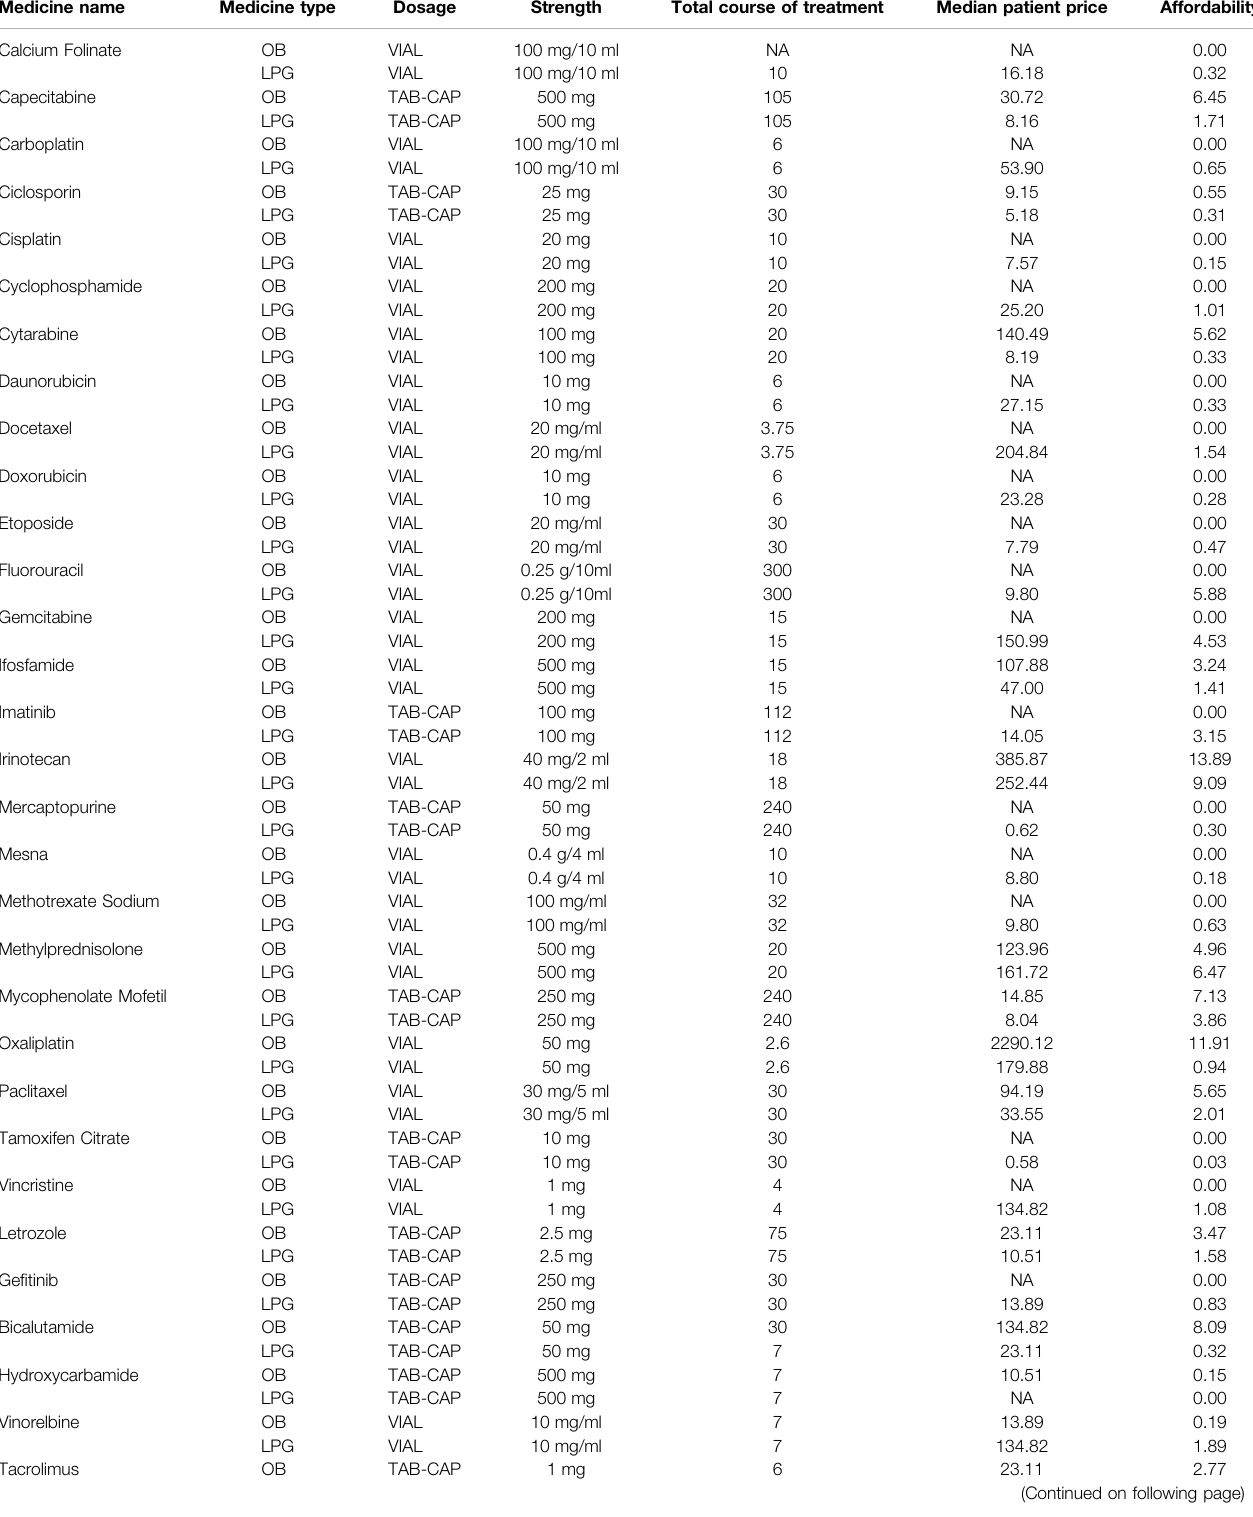
TABLE 4 | Affordability of anticancer medicines based on 20% of the minimum household monthly income in Hubei